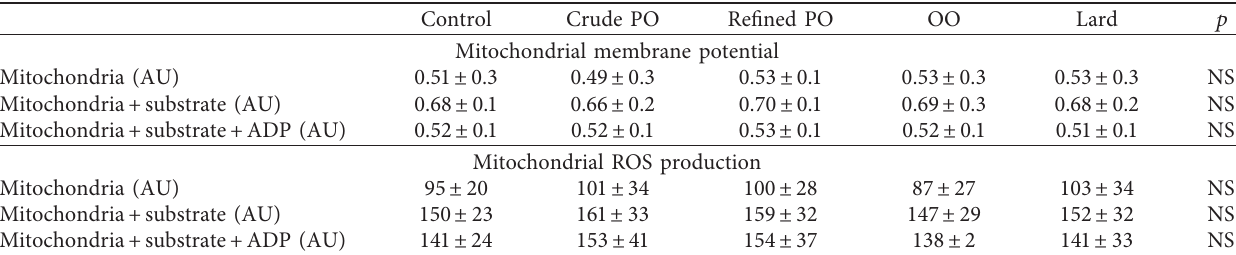
Figure 2: Effect of high dietary intake of palm oil, olive oil, and lard on hepatic lipid accumulation and steatosis. (a) Liver histology sections from a representative rat of each group, magnification 200x; (b) histograms represent liver lipid area quantification. The results are expressed as mean values ± SD, n � 7-8 animals per group. The limit of statistical significance was set at p < 0 . 05. Bar graphs with different letters (a, b, and c) are significantly different. OO, olive oil; PO, palm oil. Table 2: Effect of diets on liver mitochondrial membrane potential and ROS